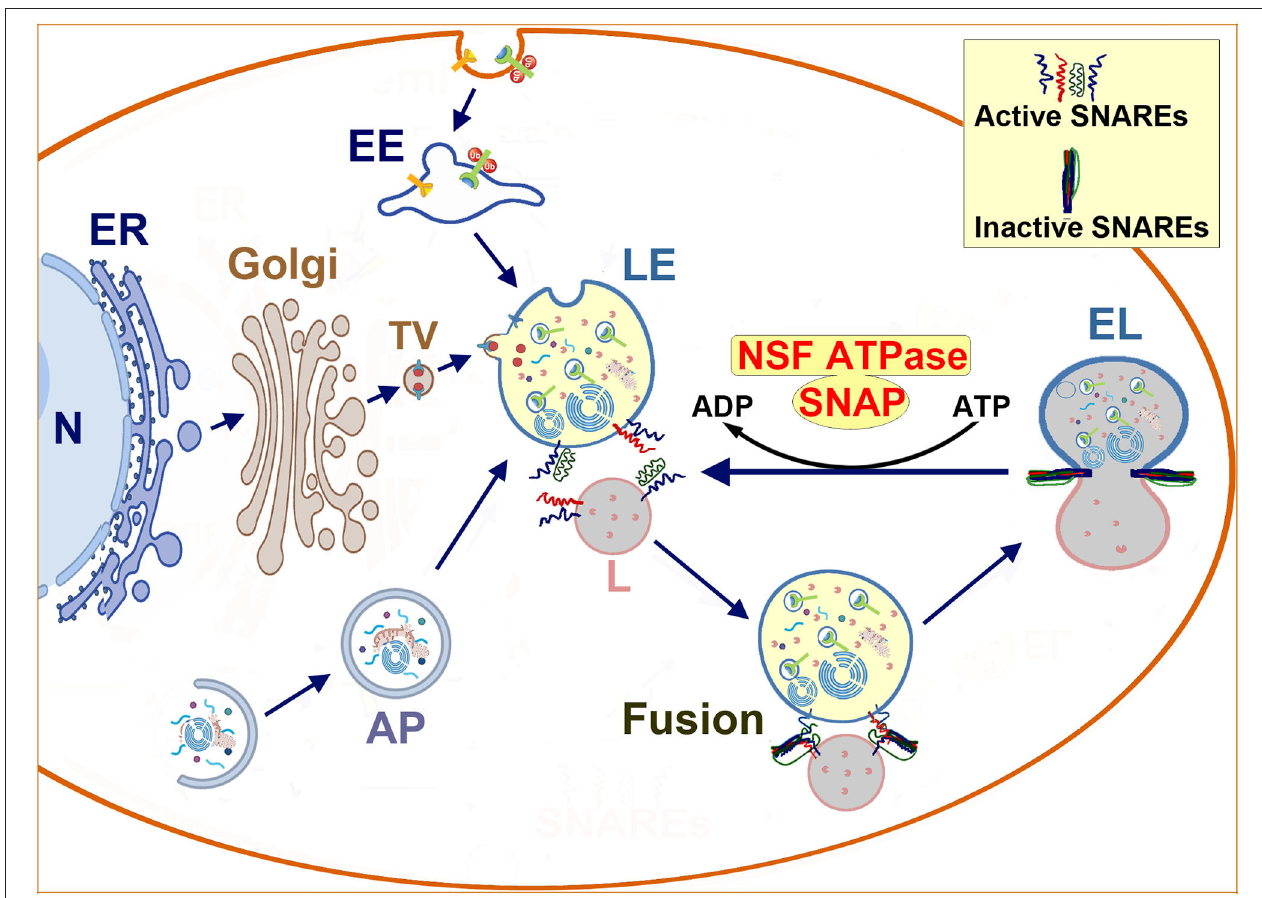
FIGURE 1 | Schematic diagram of endolysosomal trafficking: endolysosomal hydrolytic enzymes, membrane components, and structural proteins are synthesized on the ER-associated polyribosomes, and modified in the ER and the Golgi lumen. Next, they are transported via vesicles to the late endosome. The late endosome also receives incoming cargos from the endocytic and autophagic pathways. The enzyme- and cargo-loaded late endosome fuses with the terminal lysosome to form an endolysosome to digest cargos. Afterwards, the endolysosome reforms into a terminal lysosome for the next round of fusion. The membrane fusion is mediated by the NSF-SNAP-SNAREs machinery and assisted by other proteins such as HOPS complexes and Rab7. Interactions between SNAREs from two opposite lipid membranes bring two membranes together to execute the fusion. After fusion, SNAREs form inactive complexes that must be dissociated and reactivated by the cooperative action of NSF ATPase and SNAP. N, nucleus; ER, endoplasmic reticulum; Golgi, Golgi apparatus; TV, transport vesicle; EE, early endosome; AP, autophagosome; LE, late endosome; L, lysosome; NSF, N-ethylmaleimide Sensitive Factor (ATPase); SNAP, soluble NSF attachment protein; SNARE, SNAP